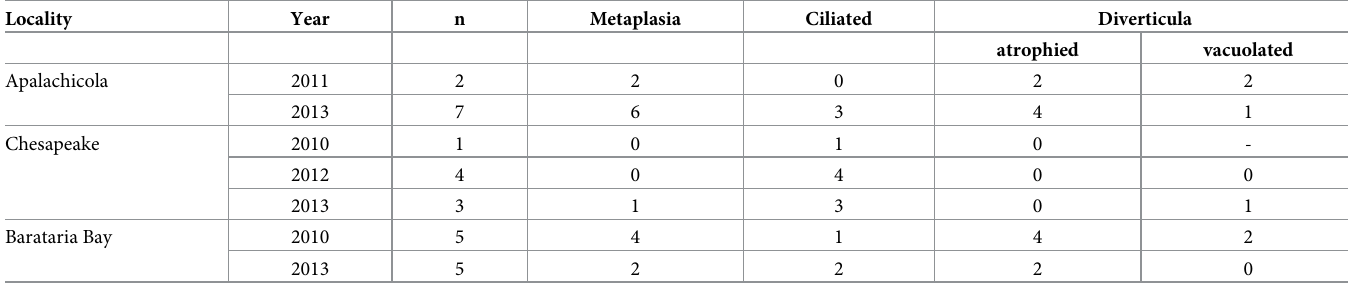
Table 2. Specimens and digestive tracts examined. n—number of specimens. Metaplasia indicates the number of specimens that exhibited some form of metaplasia, including the absence of cilia on digestive tract diverticula, and whether those diverticula were atrophied and/or possessed heavily vacuolated tissues.